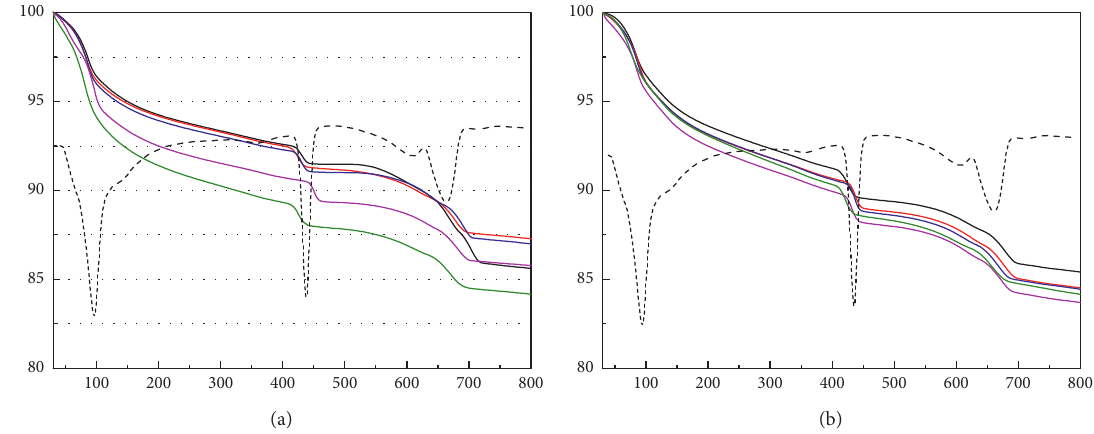
Figure 13: TGA and DTA curves of the HCS samples at a curing period of (a) 3 days and (b) 28